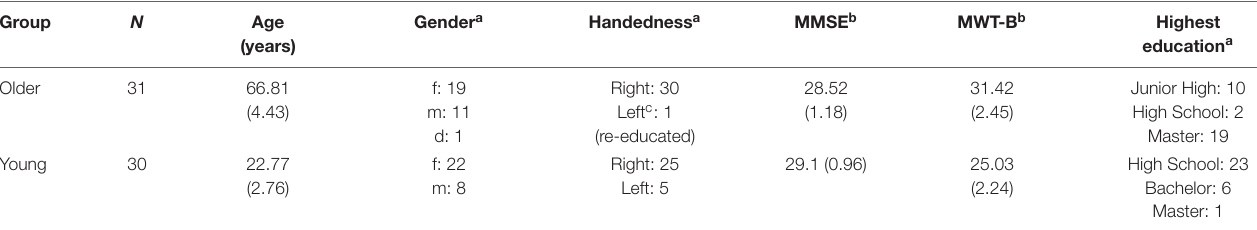
TABLE 1 | Demographic data of all participants included in the study and